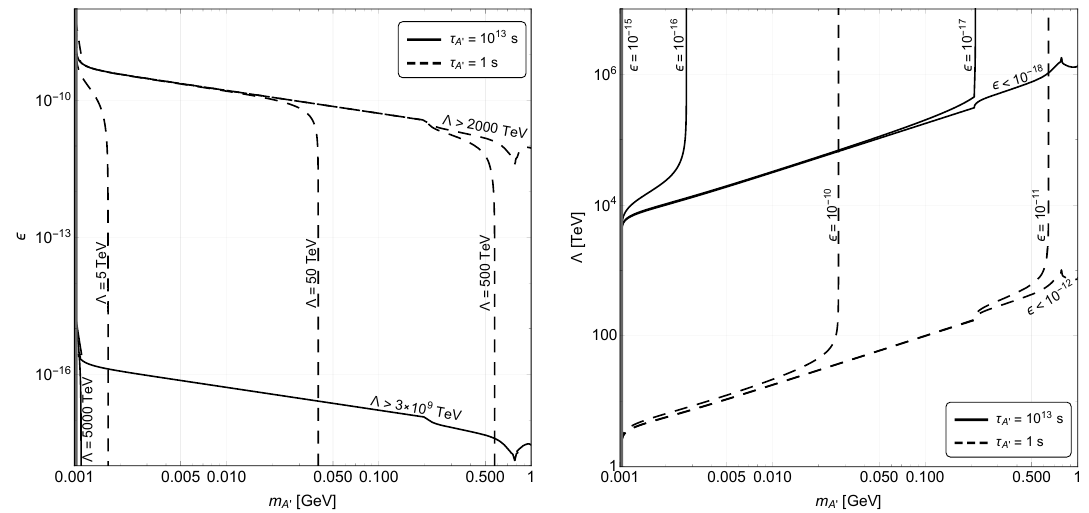
Figure 3 . Contours of dark photon constant proper lifetime for different values of the dark dipole scale Λ in the m plane (left) or for different values of the mixing parameter (cid:15) in the m A 0 − (cid:15) plane (right). In both cases we fix d = 1 e